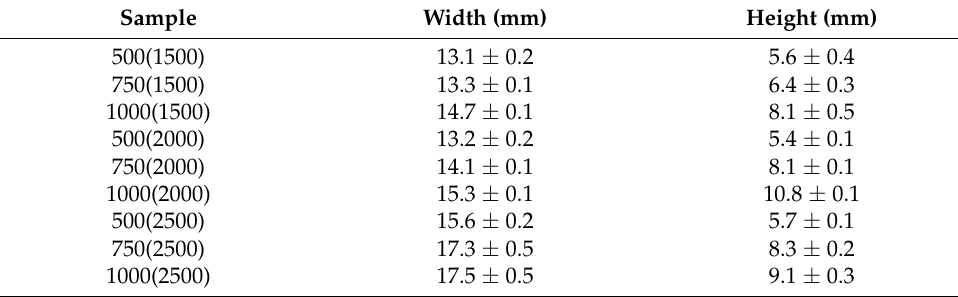
Figure 2. Overview of 3D printed scaffold geometries: ( a ) 500(1500); ( b ) 750(1500); ( c ) 1000(1500); ( d ) 500(2000); ( e ) 750(3000); ( f ) 1000(2000); ( g ) 500(2500); ( h ) 750(2500); ( i ) 1000(2500): where the first number corresponds to the pore size and the second number corresponds to the strand width; white bar = 500 µ m; images captured with KEYENCE 3D laser scanning microscope VK-X210. Table 3. Comparison of the dimensions of the different